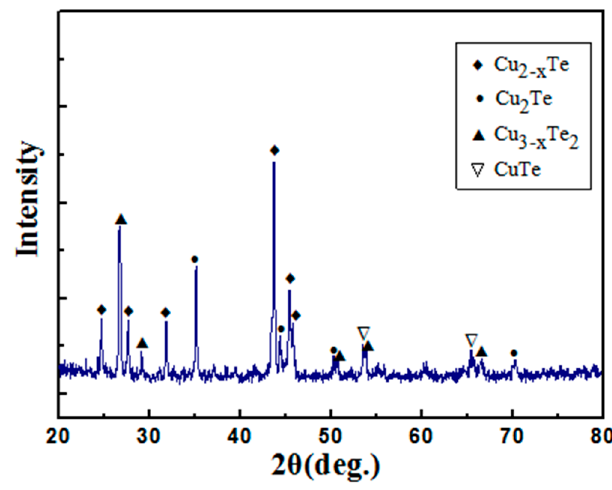
Figure 1. X-ray diffraction pattern of Cu–Te alloy powder.